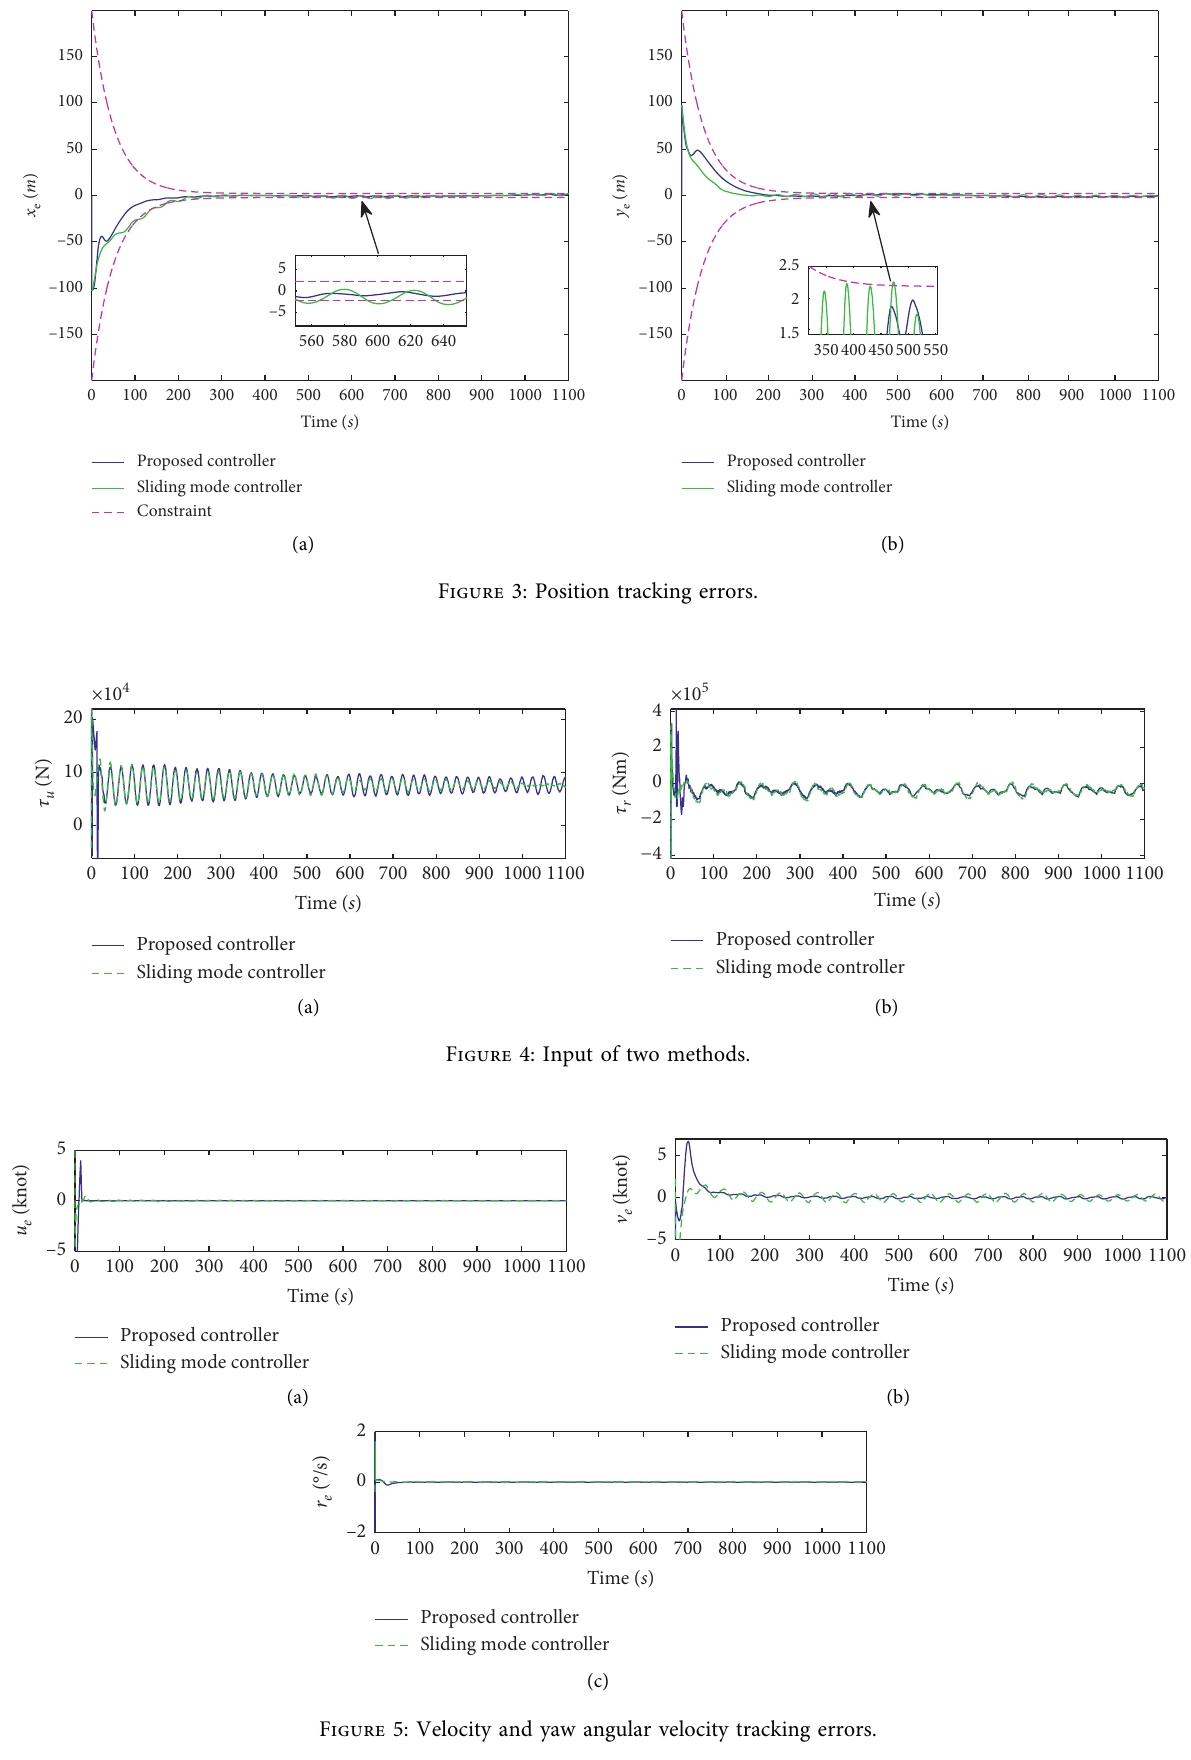
Figure 5: Velocity and yaw angular velocity tracking